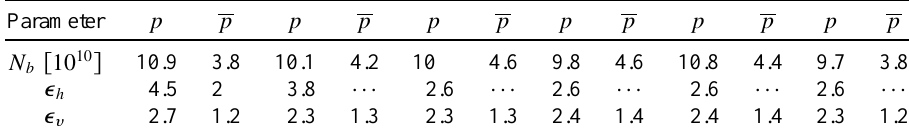
TABLE I. Typical parameters at the start of a 1988 pp run in the SPS. The ratio of beam-beam parameters in the two planes was j (cid:2) 2 (cid:3) (cid:1) j (cid:2) 1 (cid:3) (cid:8) 0.8 ; the beam-size ratio was roughly a (cid:1) 1.5 .